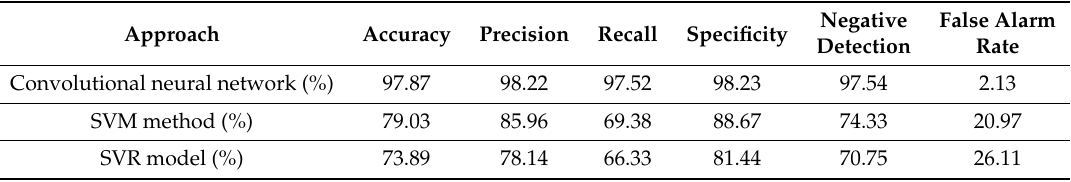
Table 33. Comparison of detection evaluation indices among the three methods for generator faults.